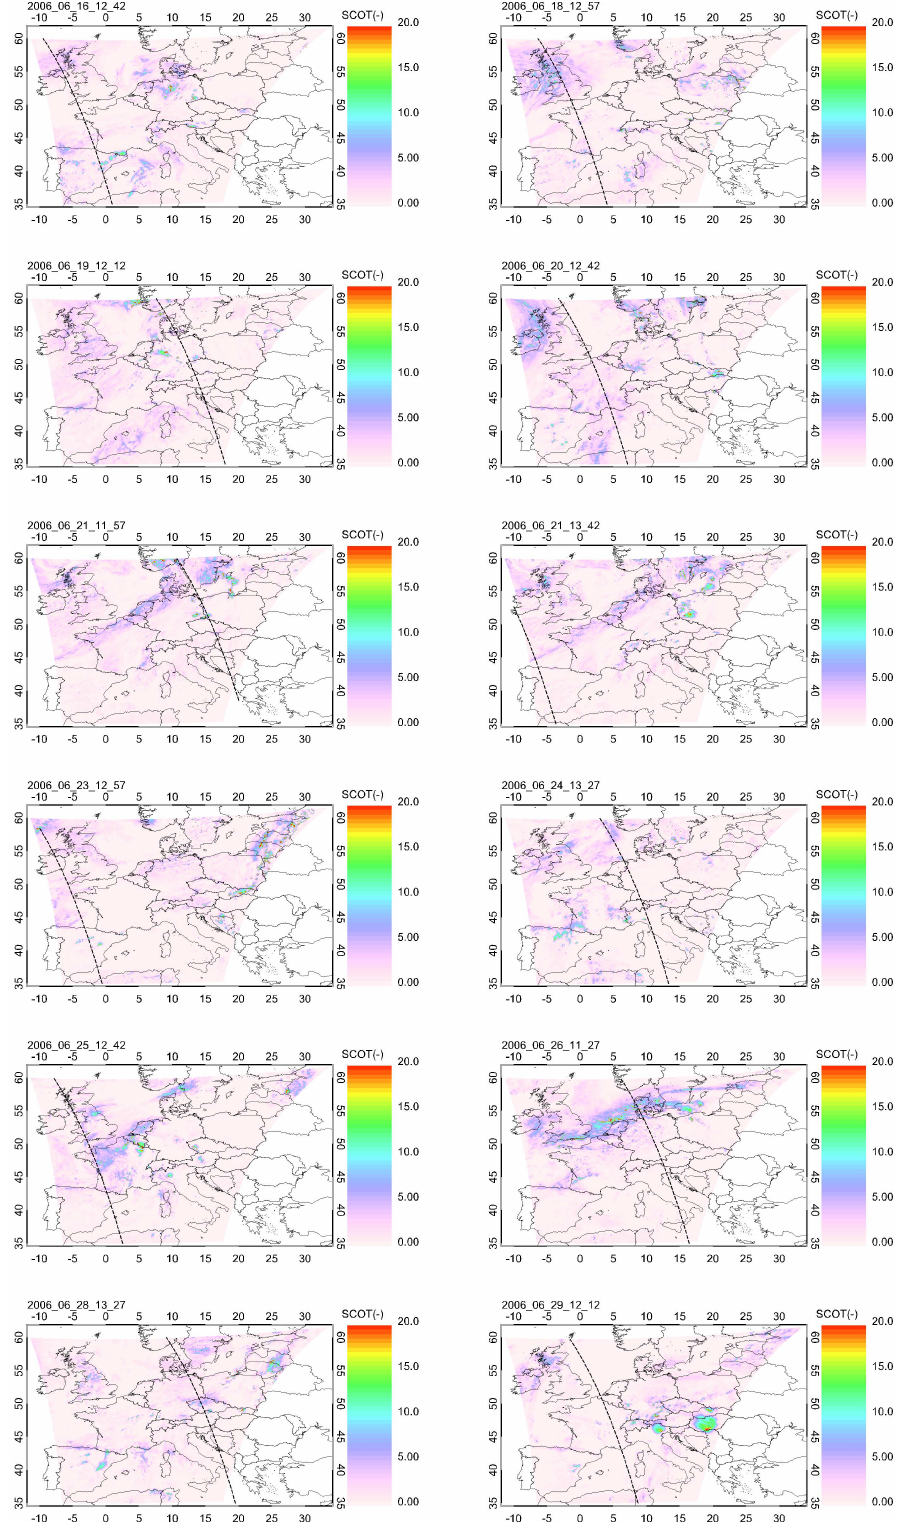
Fig. 3. SCOT fields at several selected instants, shown on top left of each map, corresponding to passes of the CloudSat instrument. The CloudSat passes are denoted by the dashed